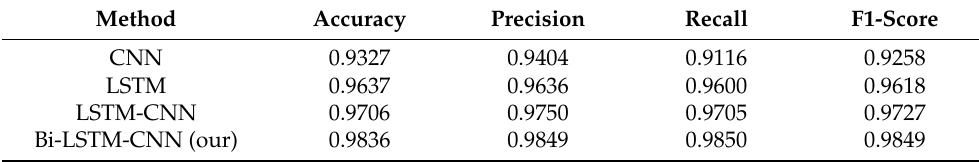
Table 3. Landmark identification performances of different models in the collected dataset.